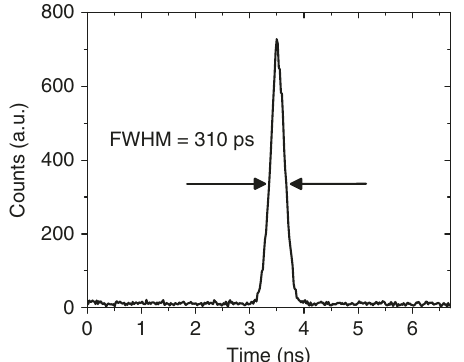
Fig. 4 Ge-on-Si single-photon avalanche diode (SPAD) jitter. Timing histogram for a 100 µ m diameter SPAD at an excess bias of 5.5% and a temperature of 78 K with incident radiation at λ = 1310 nm. The jitter full- width-at-half maximum (FWHM) was 310